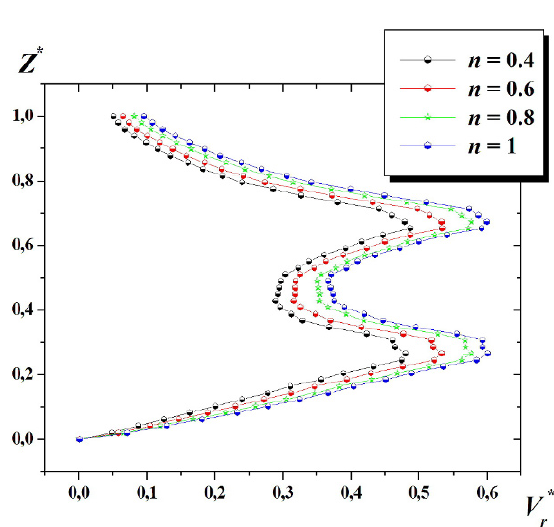
Figure 7. Tangential velocity for double helical ribbon impeller, at Re g = 60 , Z ∗ = 0 . 48 , θ = 90 0 .